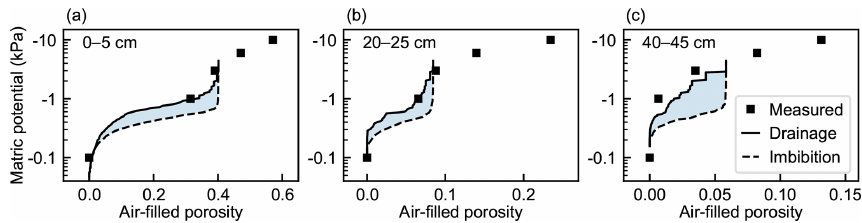
Figure 5. Simulated drainage and imbibition curves for selected peat samples from (a) 0–5cm, (b) 20–25cm, and (c) 40–45cm depths and the corresponding measured air-filled porosity values obtained with Eqs. (1) and (2).